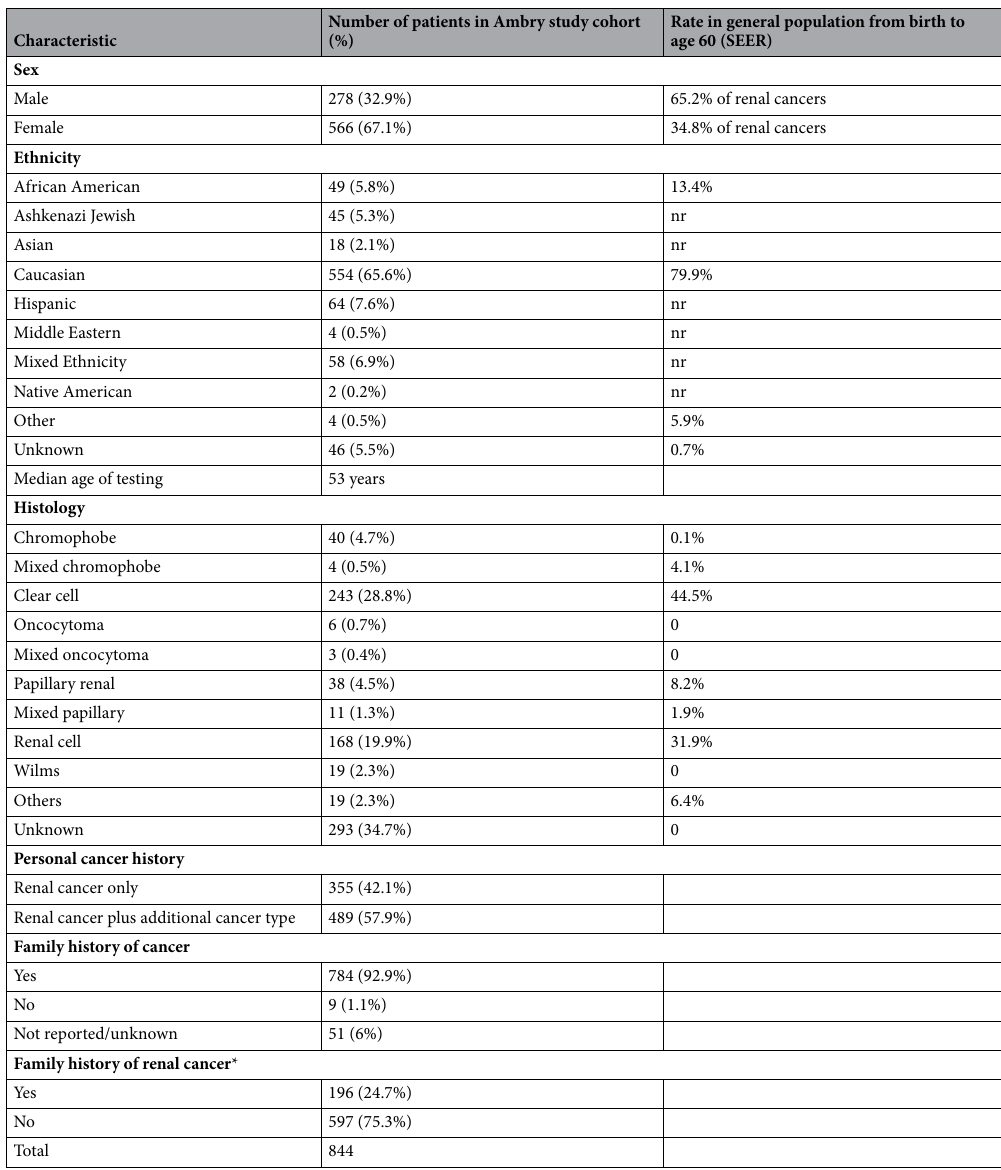
Table 1. Demographics and clinical characteristics of RC patients in the Ambry Genetics study cohort. Demographics and clinical characteristics of the RC cases in the study cohort were compared to those of RC (from birth to age 60) in the SEER data. Personal and family history of cancer were reported for the cases in the study cohort. *For family history of renal cancers, numbers include only those who reported on cancer history (n = 793). nr not reported. SEER data included 149 types of renal cancer histologies, not all were represented in dataset; “other” based on other category from Ambry cohort. Family histories as self-reported on the intake form/medical records and have not been